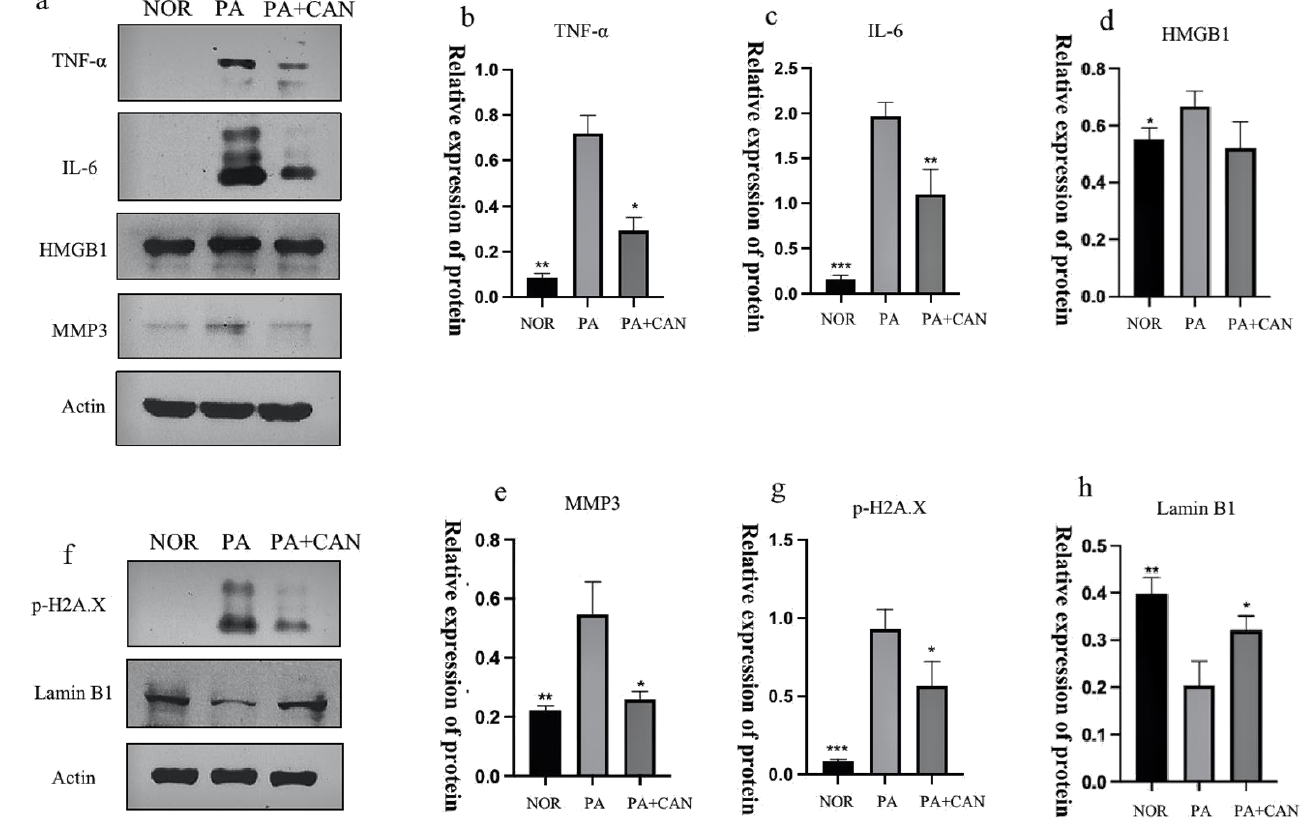
Figure 4. CAN regulated the senescence-associated secretory phenotype (SASP) and senescence signature protein content. ( a – e ) CAN (5 µ g/mL) inhibited PA-induced increases in TNF- α , IL-6, HMBG1 and MMP3. ( f – h ) CAN (5 µ g/mL) inhibited PA-induced increases in p-H2A.X and lamin B1 reduction. Data are expressed as the means ± SD ( n = 3); * p < 0.05, ** p < 0.01, *** p < 0.001 vs.